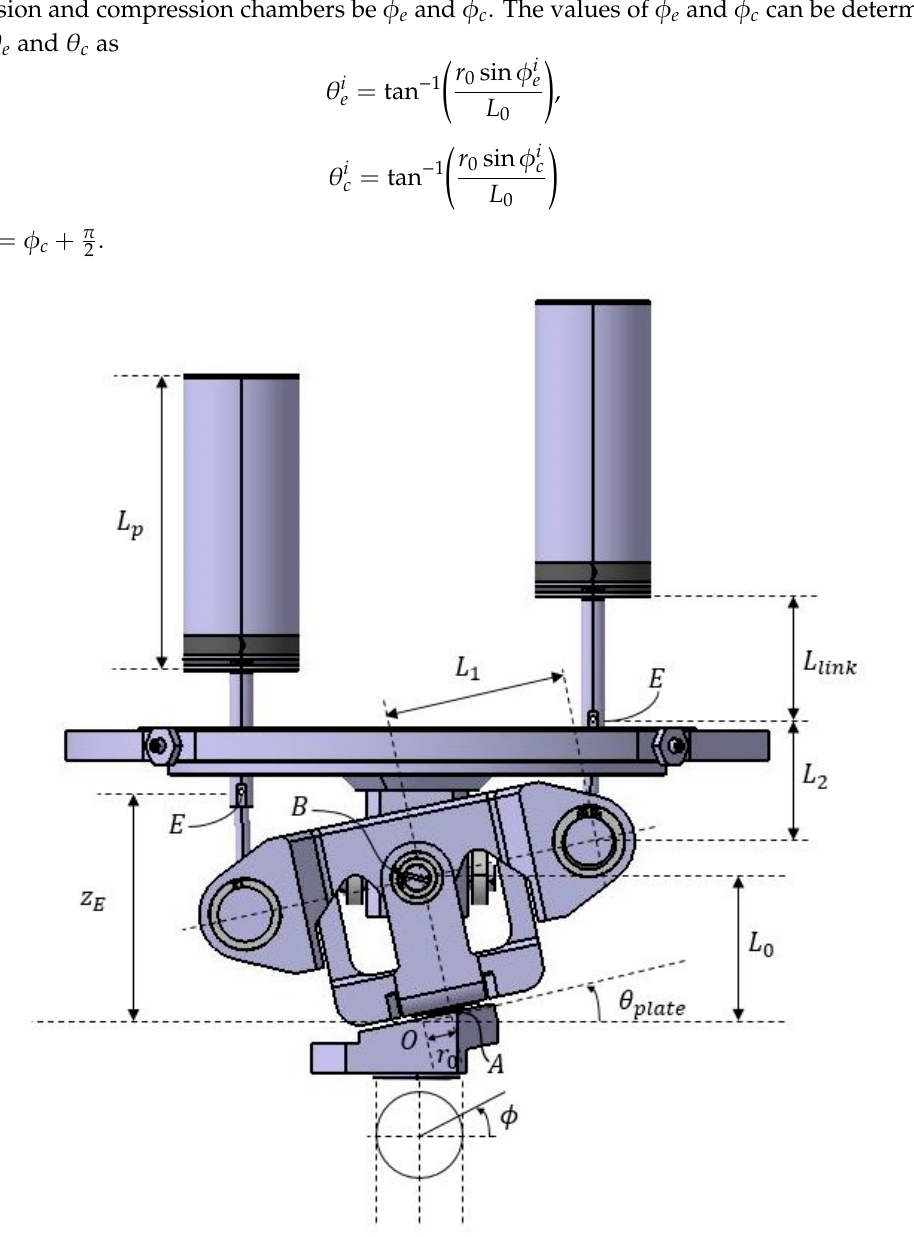
Figure 3. Dimension variables of wobble-yoke mechanism.